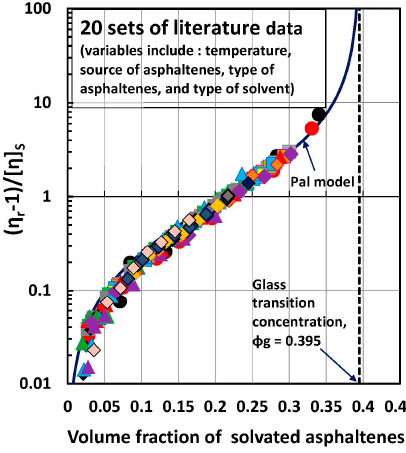
versus φ S . Figure 13. Twenty viscosity datasets of asphaltene suspensions plotted as S